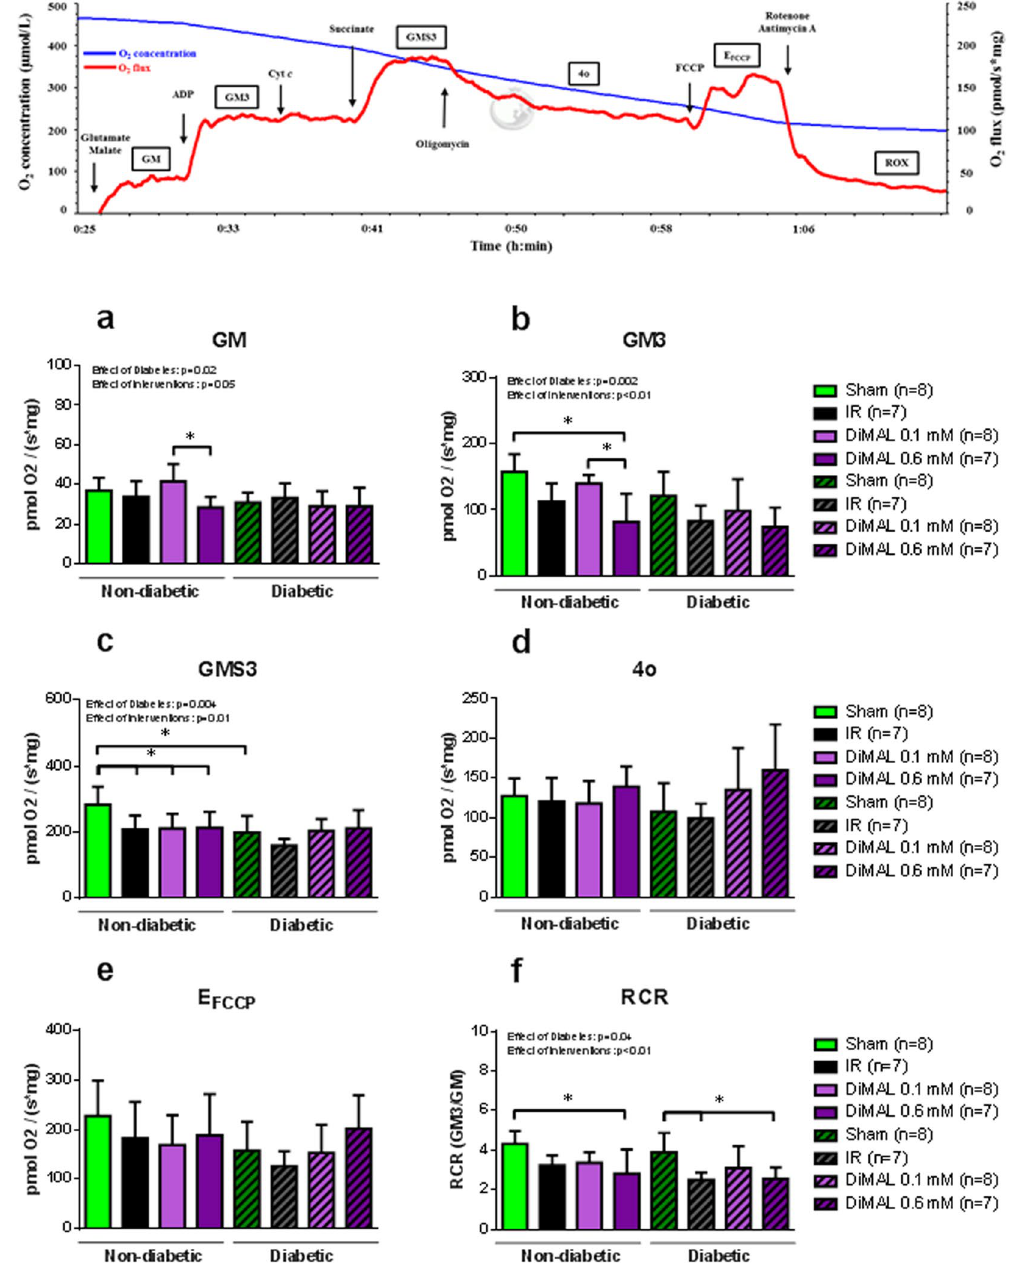
Figure 5. Isolated rat heart study - Mitochondrial respiratory capacity. Representative graph of mitochondrial respiratory capacity from a Sham heart. Below mitochondrial respiratory capacity. GM, state 2 respiration with glutamate + malate ( a ); GM3, state 3 respiration with glutamate and malate ( b ); GMS3, state 3 respiration with glutamate, malate and succinate ( c ); 4o, state 4 respiration with oligomycin ( d ); FCCP, non-coupled state by FCCP ( e ); RCR with complex I-linked substrates ( f ). Data are mean ± SD. * P < 0.05 between indicated groups. P-values at the top indicate overall effect of diabetes and interventions by two-way ANOVA,